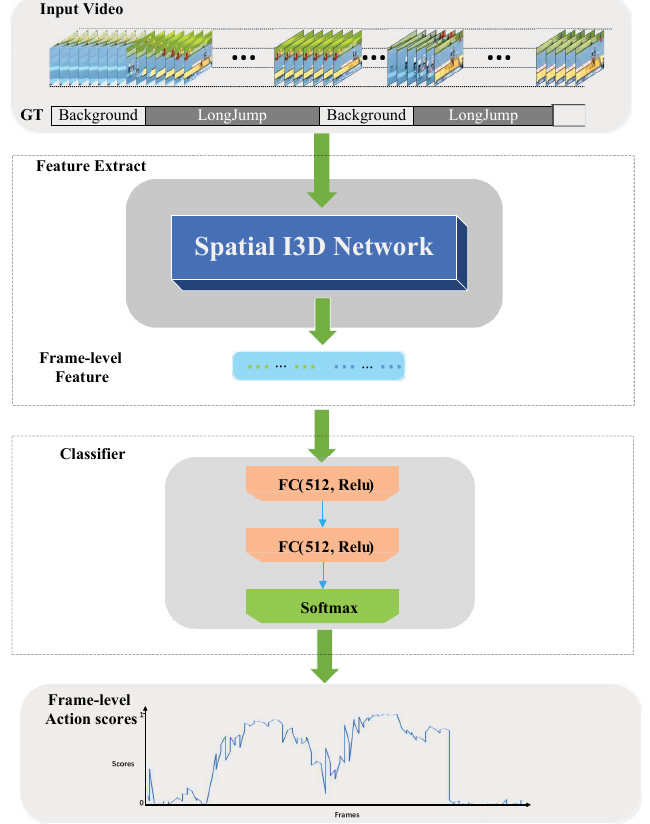
Figure 1. Architecture of the proposed action estimation network.